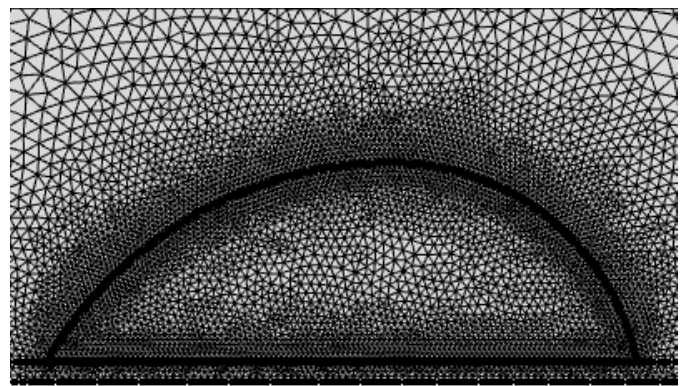
Figure 3. Typical mesh in the water